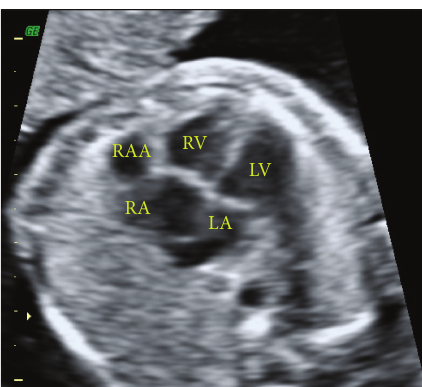
Figure 1: Aneurysmal dilatation of the right atrial appendage (RAA) which was detected in the 21st week of gestation with fetal echocardiography (RAA: right atrial appendage; RA: atrium; RV: right ventricle; LA: left atrium; LV: left ventricle).